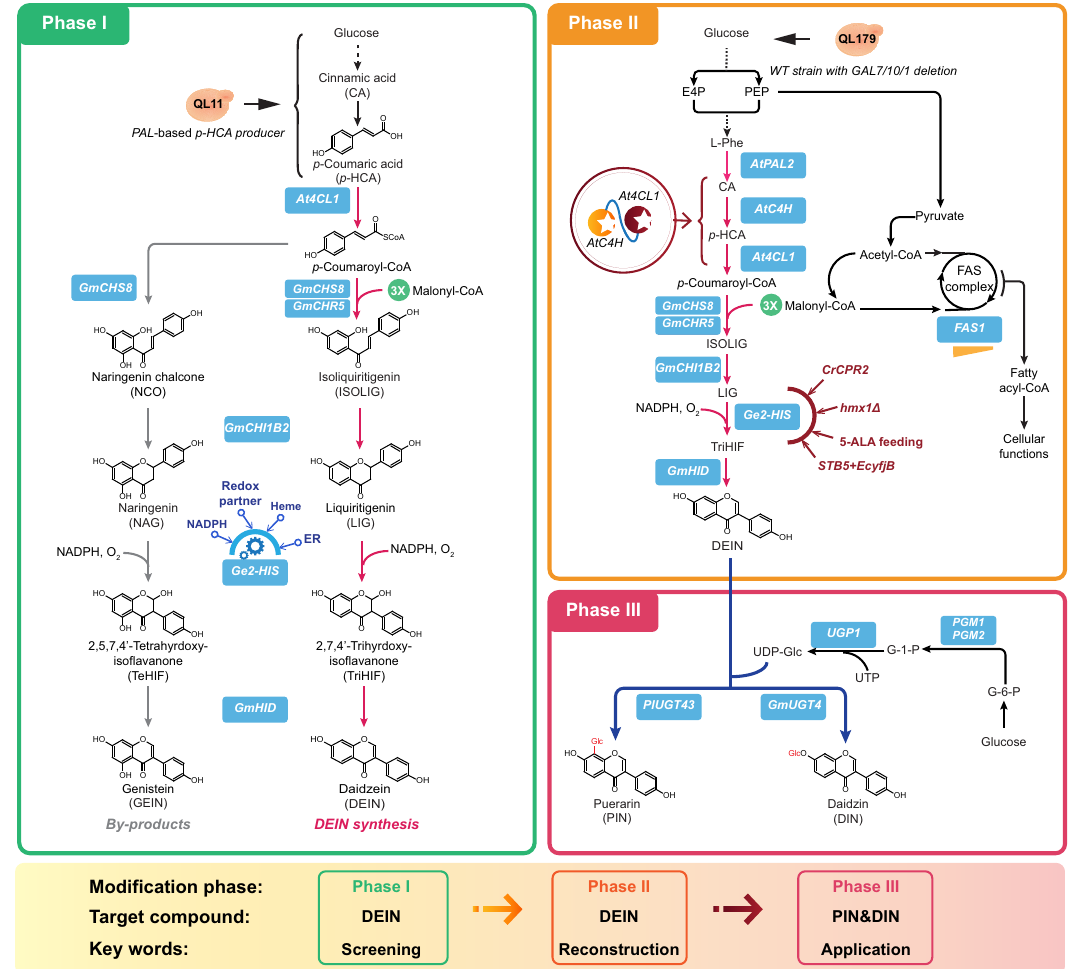
Fig. 1 Engineering the de novo biosynthesis of iso fl avonoid chemicals in yeast. A multi-phased metabolic engineering strategy was implemented to enable de novo production of iso fl avonoids, following the pipeline of screening-reconstruction-application. In screening phase I (green box), a synthetic DEIN pathway was established and metabolic factors improving the performance of rate-limiting reactions were identi fi ed using a moderate p -HCA producing platform strain QL11. In reconstruction phase II (orange box), the DEIN production was further optimized in a wild-type strain QL179 harboring the deletion of galactose utilizing genes ( GAL7 / 10 / 1) , through amplifying gene expression, enhancing substrate transfer, combining effective genetic targets identi fi ed in phase I and fi ne-tuning the expression of a key gene involved in competing metabolic pathway (orange triangle). For application phase III (magenta box), the generated DEIN platform strain was used as the starting point for the production of bioactive glucosides PIN and DIN through introducing plant glycosyltransferases and enhancing the supply of glycosyl group donor UDP-glucose. The selected plant biosynthetic genes and overexpressed yeast native genes for iso fl avonoid production were highlighted in blue boxes. Magenta arrows, designed DEIN biosynthetic pathway. Blue arrows, reactions for generating glucosides; gray arrows, byproduct pathway. At4CL1 , 4-coumarate-coenzyme A ligase 1 from Arabidopsis thaliana ; GmCHS8 , chalcone synthase from Glycine max ; GmCHR5 , chalcone reductase from G. max ; GmCHIB2 , chalcone isomerase from G. max ; Ge2-HIS , 2-hydroxyiso fl avanone synthase from Glycyrrhiza echinata ; GmHID , 2-hydroxyiso fl avanone dehydratase from G. max ; AtPAL2 , phenylalanine ammonia lyase from A. thaliana ; AtC4H , cinnamic acid-4-hydroxylase from A. thaliana ; FAS1 , beta subunit of yeast fatty acid synthetase; CrCPR2 , cytochrome P450 reductase from Catharanthus roseus ; STB5 , yeast native transcriptional factor; EcyjfB , NAD + kinase from Escherichia coli ; GmUGT4 , iso fl avone 7- O - glucosyltransferase from G. max ; PlUGT43 , iso fl avone 8- C -glucosyltransferase from Pueraria lobate ; UGP1 , UDP-glucose pyrophosphorylase; PGM1/2 , phosphoglucomutase 1/2. In addition, yeast heme degradation was disrupted by deleting heme oxygenase-coding gene HMX1 . ER endoplasmic reticulum, E4P erythrose-4-phosphate, PEP phosphoenolpyruvate, L-Phe L-phenylalanine, 5-ALA 5-aminolevulinic acid, UDP-Glc uridine diphosphate-glucose, UTP uridine triphosphate, G-6-P glucose-6-phosphate, G-1-P C09) among all resultant strains (C01 − C11, Fig. 2b). In addition, ( Petunia hybrida ), Pc4CL2 ( Petroselinum crispum ) and a mutant strains C01, C04 − 05 and C10 generated no detectable amounts of At4CL1m (I250L, N404K, I461V) 29 , were overexpressed to generate LIG (strains C12 − C17) (Supplementary Fig. 3a); iso fl avonoid intermediates, which could be attributed to the however, none of these genes outperformed the wild-type At4CL1 narrow substrate speci fi city of type I PsCHI1 (strain C01) and low (C09) (Fig. 2c). Also, no improvement on LIG production was enzymatic activity of PlCHR in yeast (strains C04-05 and C10), observed for strains expressing alternative variants of CHS respectively (Fig. 2b and Supplementary Fig. 3b). Subsequently, (strains C18 − C20) or CHI (strains C21 − C22) (Fig. 2c and individual gene replacement in strain C09 allowed the ef fi cient Supplementary Fig. 3c). Strain C09 was therefore chosen as the screening of additional 4CL, CHS, and CHI variants. Five plant starting strain for further engineering to produce DEIN. 4CL-coding genes, including Pl4CL1 , Gm4CL3 , At4CL2 , Ph4CL1